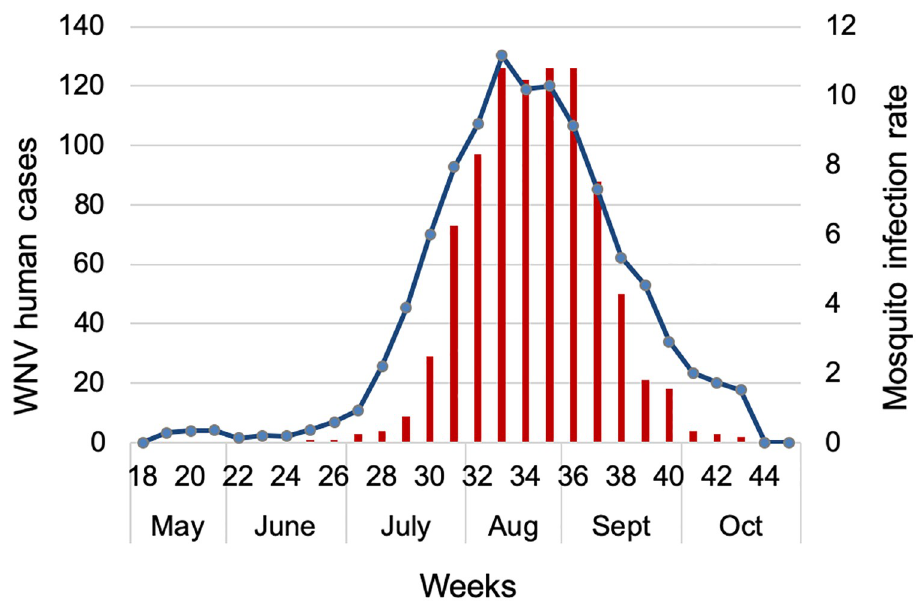
Fig 1. Cumulative weekly human WNV cases (red bars) and mosquito infection rate (blue line) from 2005–2016 in Cook and DuPage counties, Illinois.